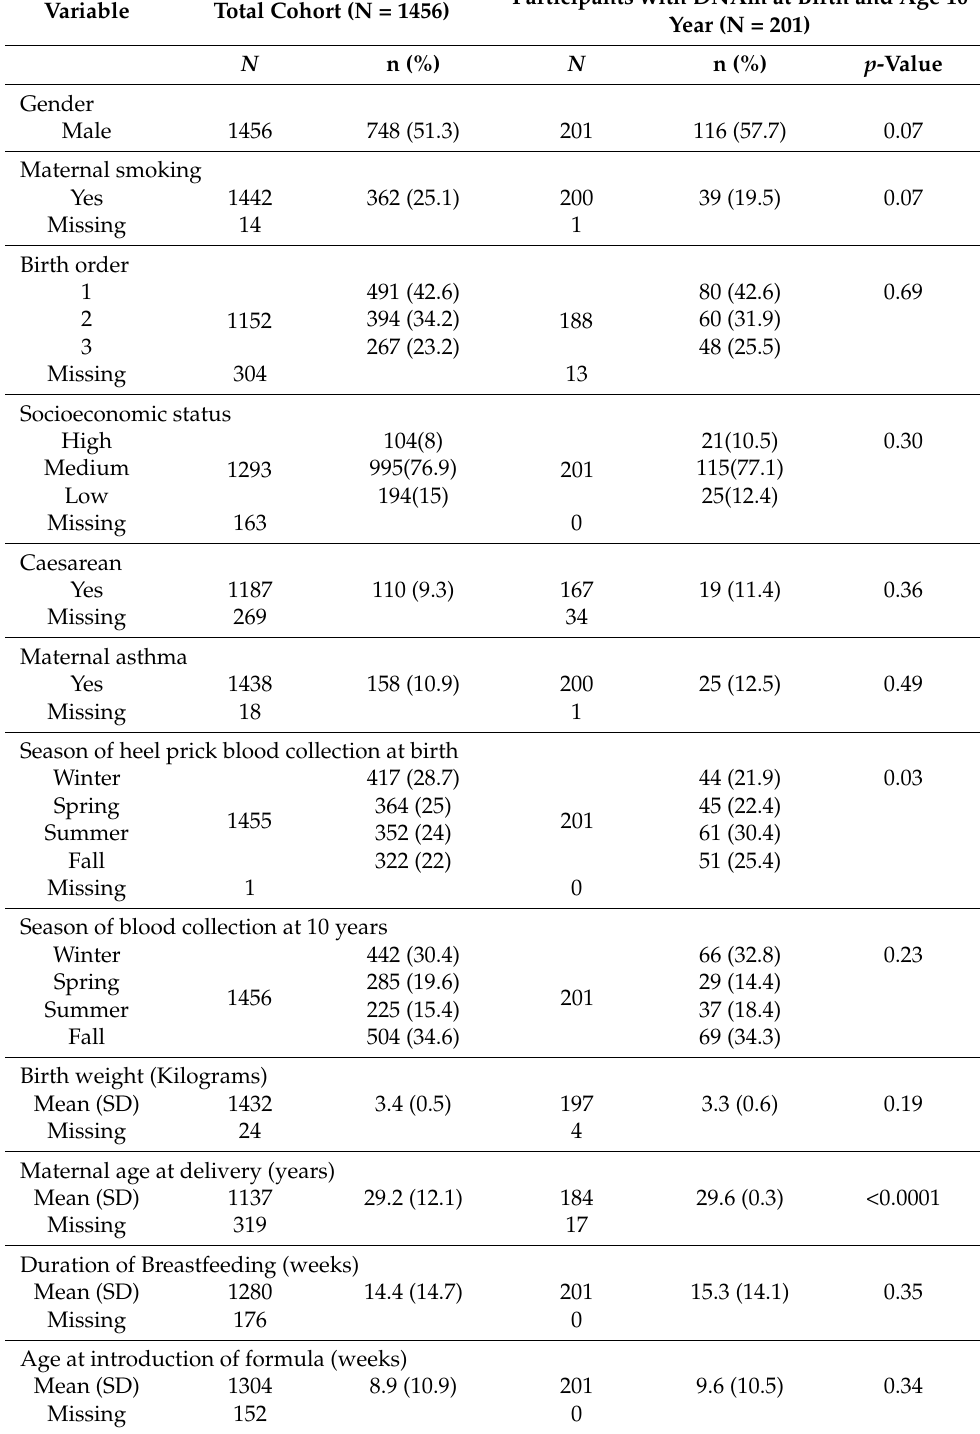
Table 1. Comparing characteristics of the analyzed sample consisting of participants with DNA methylation data at both birth and age 10 with the initial Isle of Wight birth